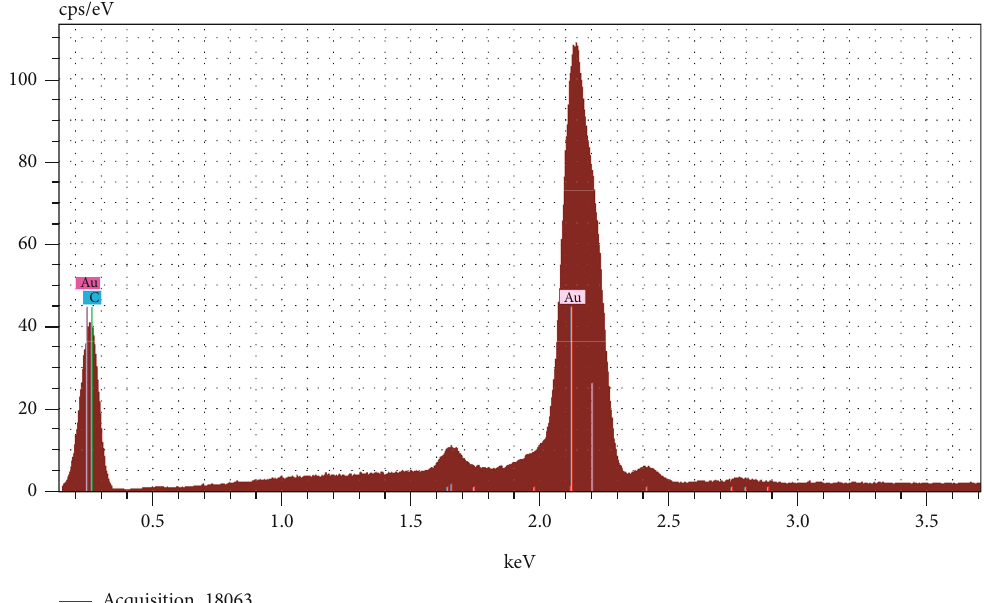
Figure 5: Result of energy spectrum analysis for black solid (775 °